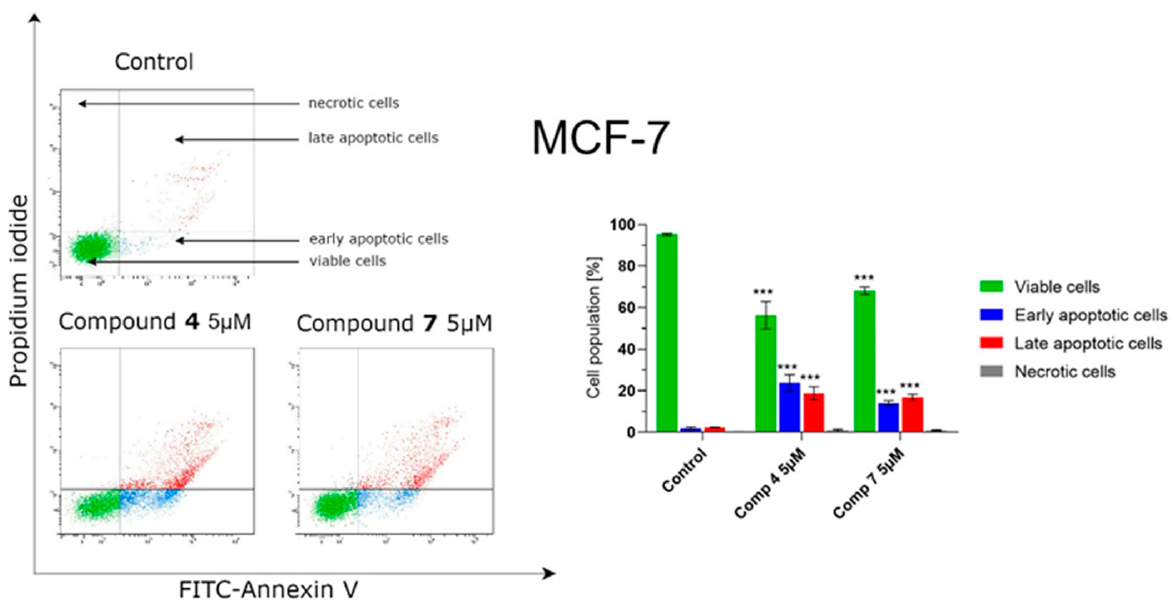
Figure 15. Flow cytometry analysis of apoptosis induction in the MCF-7 breast cancer cells after 24 h incubation with the compound 4 (5 µM) and the compound 7 (5 µM) staining with Annexin V-FITC/PI). The obtained results are presented as mean values ± SD obtained from three inde- pendent experiments (n = 3) conducted in duplicate. *** p < 0.001 compared with. control.